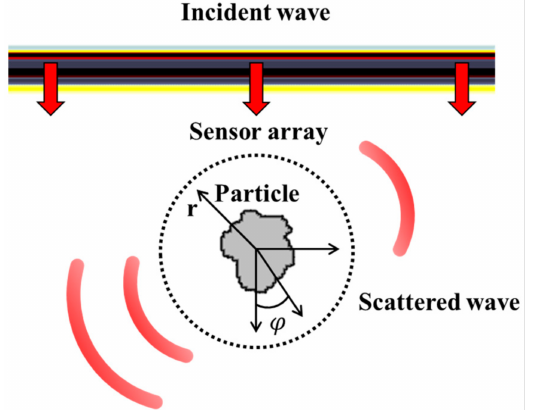
Figure 10. Schematic illustration of scattering cross-section calculation.